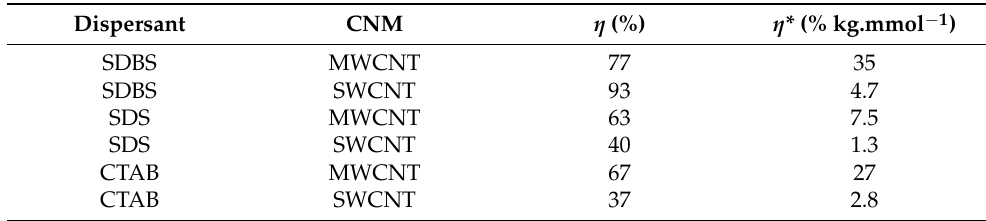
Table 1. η and η * values for a range of CNT dispersions [27]. Table adapted with permission from [27] Copyright © 2015 American Chemical